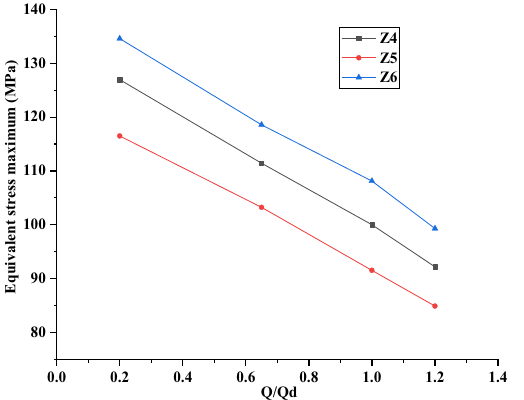
Figure 14. Equivalent stress maximum distribution of three models under four working conditions.